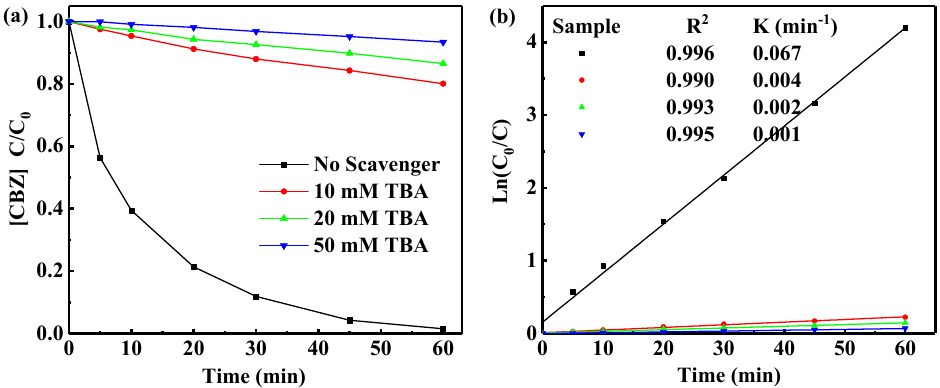
Figure 11. ( a ) Degradation of CBZ by UV-LED/TiO 2 using different concentrations of TBA ( b ) The pseudo-first-order kinetic models of CBZ degradation by UV-LED/TiO 2 using different concentrations of TBA.